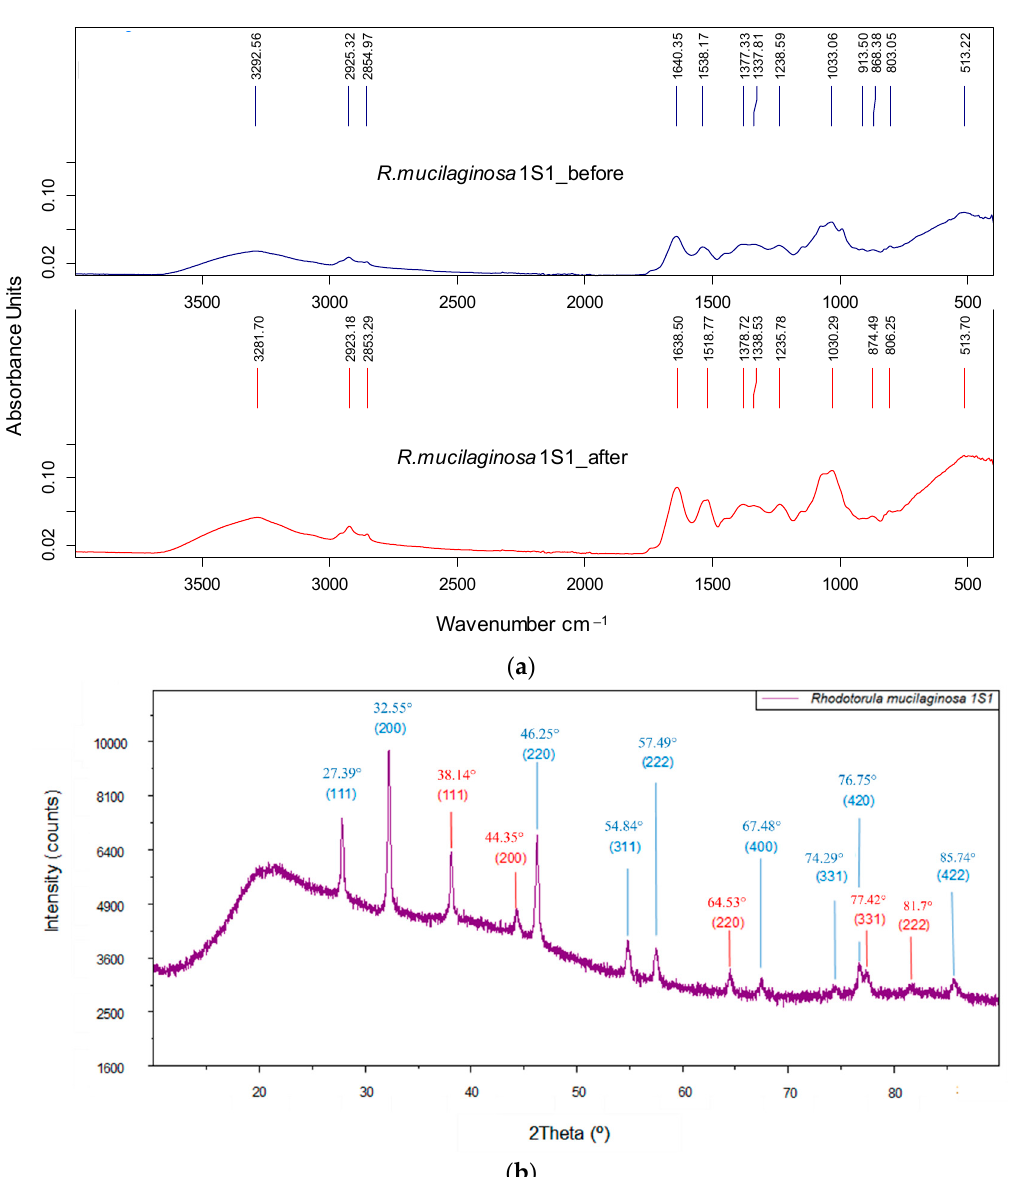
Figure 4. ( a ): FT-IR spectra obtained before and after the Ag(I) biosorption step for the biomass of Rhodotorula mucilaginosa 1S1. ( b ): XRD spectrum for biomass of Rhodotorula mucilaginosa 1S1 in which the sequence of peaks and the assignment of planes of the AgCl-NPs (blue) and Ag-NPs (red) can be seen.